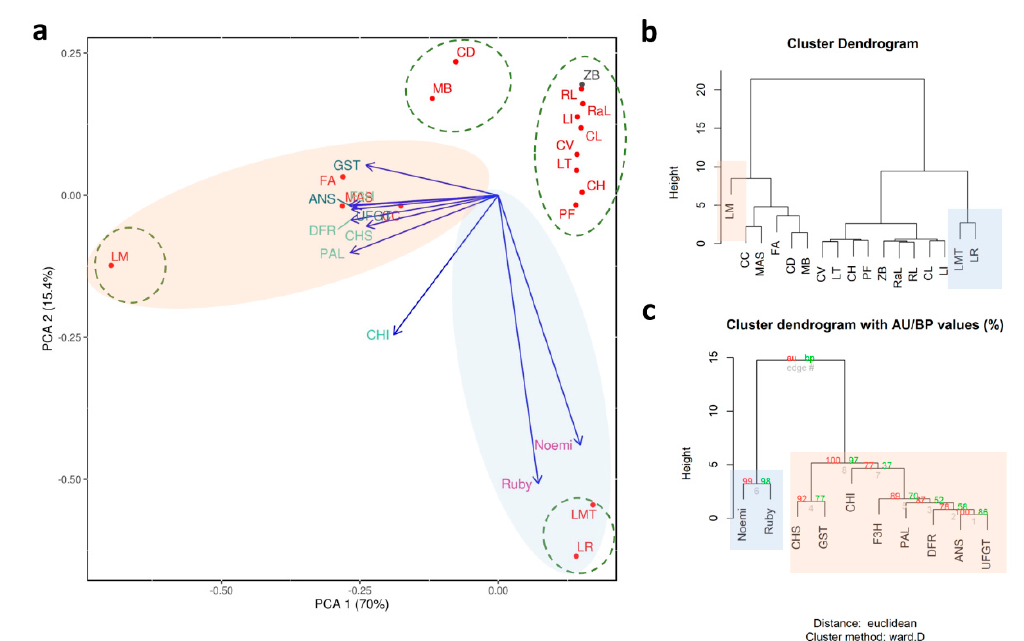
Figure 3. Statistical analyses carried out on accessions characterized by the pigmentation of young leaves. ( a ) Principal component analysis; cluster dendrograms based on the distribution of expression data focusing on ( b ) accessions and ( c ) genes where AU refers to Approximately Unbiased p -value and BP is for Bootstrap Probability value. Each accession is indicated by a code: ‘Zagara bianca’—ZB,